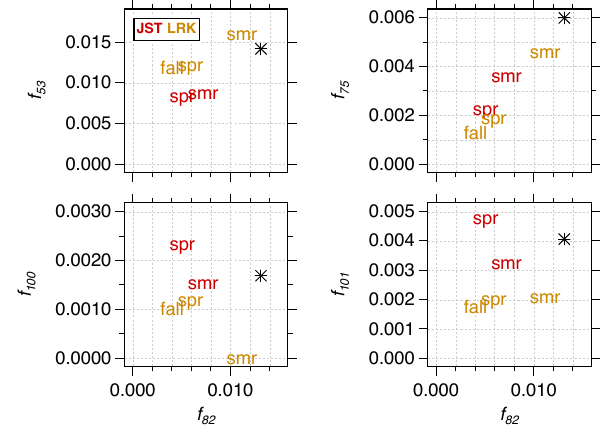
) , m/z 75 5 ) and m/z 101 2